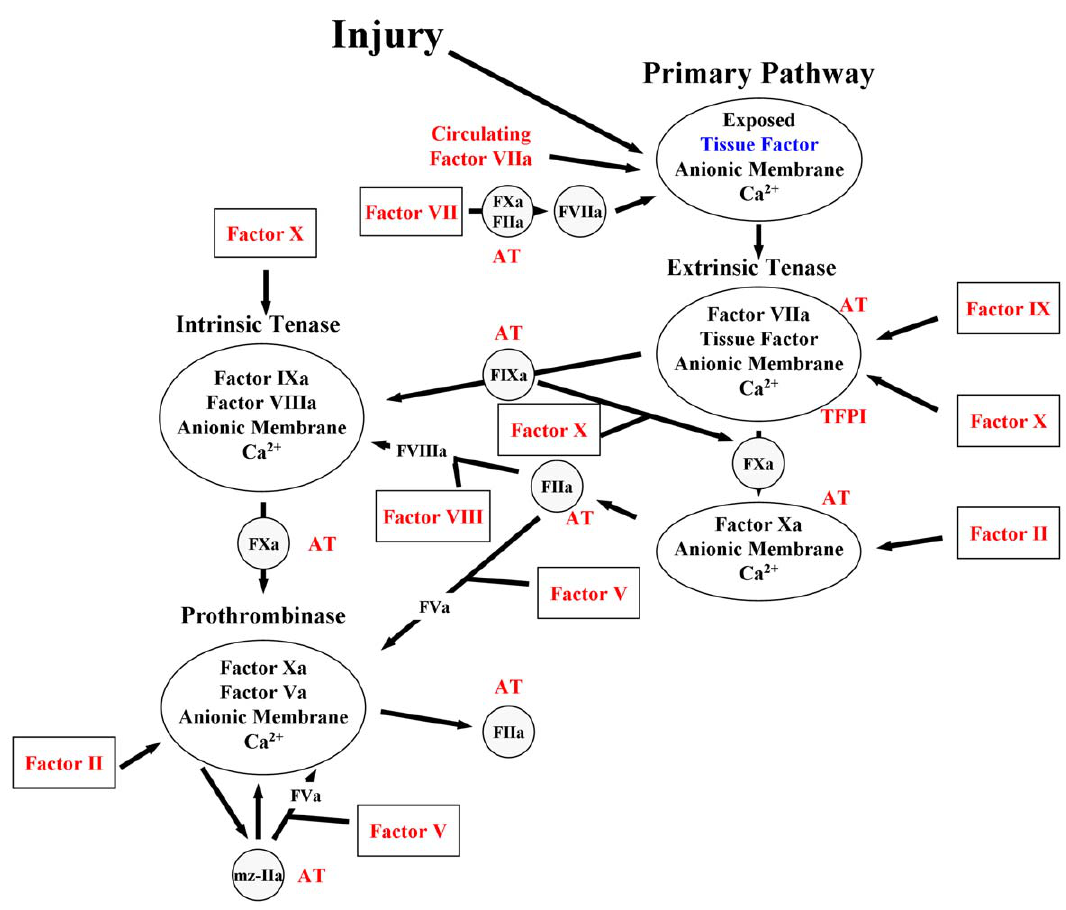
Figure 1. Schematic of the computational model of the tissue factor pathway. The multicomponent processes encompassed in the computational model are illustrated as either: enzymes (open circle), inhibitors (hatched circle), zymogens (open boxes) or complexes (open ovals). Upon injury to the vessel wall, tissue factor, the cofactor for the extrinsic tenase complex, is exposed to circulating factor VIIa and forms the vitamin K dependent complex the extrinsic tenase. Factor IX and factor X are converted to their serine proteases factor IXa (FIXa) and factor Xa (FXa) which then form the intrinsic tenase and the prothrombinase complexes, respectively. The combined actions of the intrinsic and extrinsic tenase and the prothrombinase complexes lead to an explosive burst of the enzyme thrombin (IIa). The procoagulant response is down regulated by the stoichiometric inhibitors tissue factor pathway inhibitor (TFPI) and antithrombin (AT). TFPI serves to attenuate the activity of the extrinsic tenase trigger of coagulation. AT directly inhibits thrombin, FIXa and factor Xa. The proteins in which the concentrations from individual subjects are used are shown in red. Tissue factor in blue is arbitrarily set to 5 pM. Circulating FVIIa is set at 1% of the concentration of FVII from each individual.